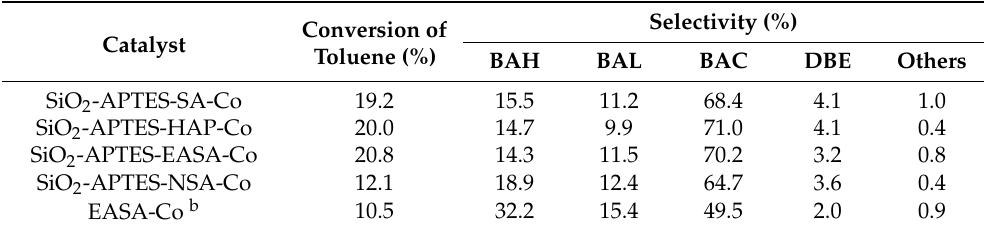
Table 3. Catalytic performance of Co-Schiff base catalysts synthesized by different ligands for aerobic oxidation of toluene under solvent-free conditions a . Selectivity (%) Conversion of Catalyst Toluene (%) BAH BAL BAC DBE Others SiO 2 -APTES-SA-Co 19.2 15.5 SiO 2 -APTES-HAP-Co SiO 2 -APTES-EASA-Co SiO 2 -APTES-NSA-Co 0.9